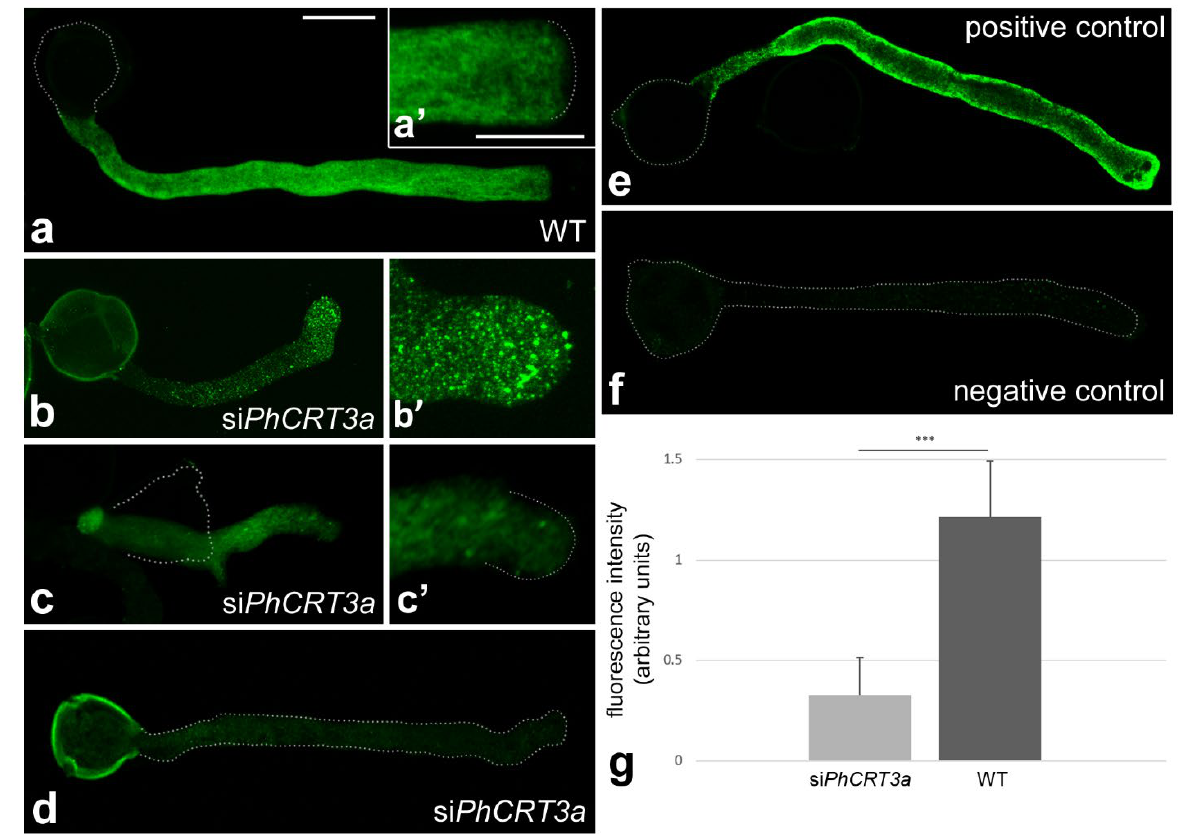
Figure 6. Quantitative analyses of PhCRT3a mRNA in WT ( a ) and si PhCRT3a ( b – d ) pollen tubes using fluorescent in situ hybridization (FISH). In WT tubes, the transcripts are diffusely distributed through- out the tube shank, extending from the base to the subapical zone ( a , a’ ). In contrast, shorter si PhCRT3a pollen tubes exhibit a disrupted pattern of transcript localization ( b , b’ – c , c’ ), while elongated tubes are devoid of hybridization signals ( d ). Positive control— PhCRT1 mRNAs in an elongated si PhCRT3a pollen tube ( e ). Negative FISH control without the molecular probe ( f ). The level of PhCRT3a tran- scripts is about 73% lower in si PhCRT3a pollen tubes compared to WT ( g ). Graphs show the relative PhCRT3a mRNA levels in pollen tubes elongating in different culture conditions (mean of 15 replicates for each experimental variant and standard deviation). Arbitrary units on the y-axis show total FISH intensity (pixels). Statistical analysis was carried out using the Mann–Whitney test (*** p ≤ 0.001). Bar: 50 µ m ( a – f ); 20 µ m ( a’ – c’